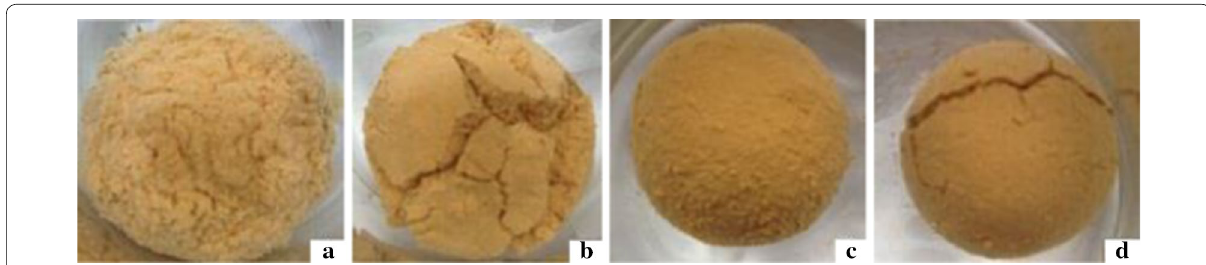
Fig. 3 The appearance of mud balls immersed in different treatment solutions for 12 h. a Distilled water, b 0.8% DEM-8, c 1.0% KCl, d 0.8% DEM-8 1.0% KCl + Table 2 Evaluation results of drilling fluid rheological